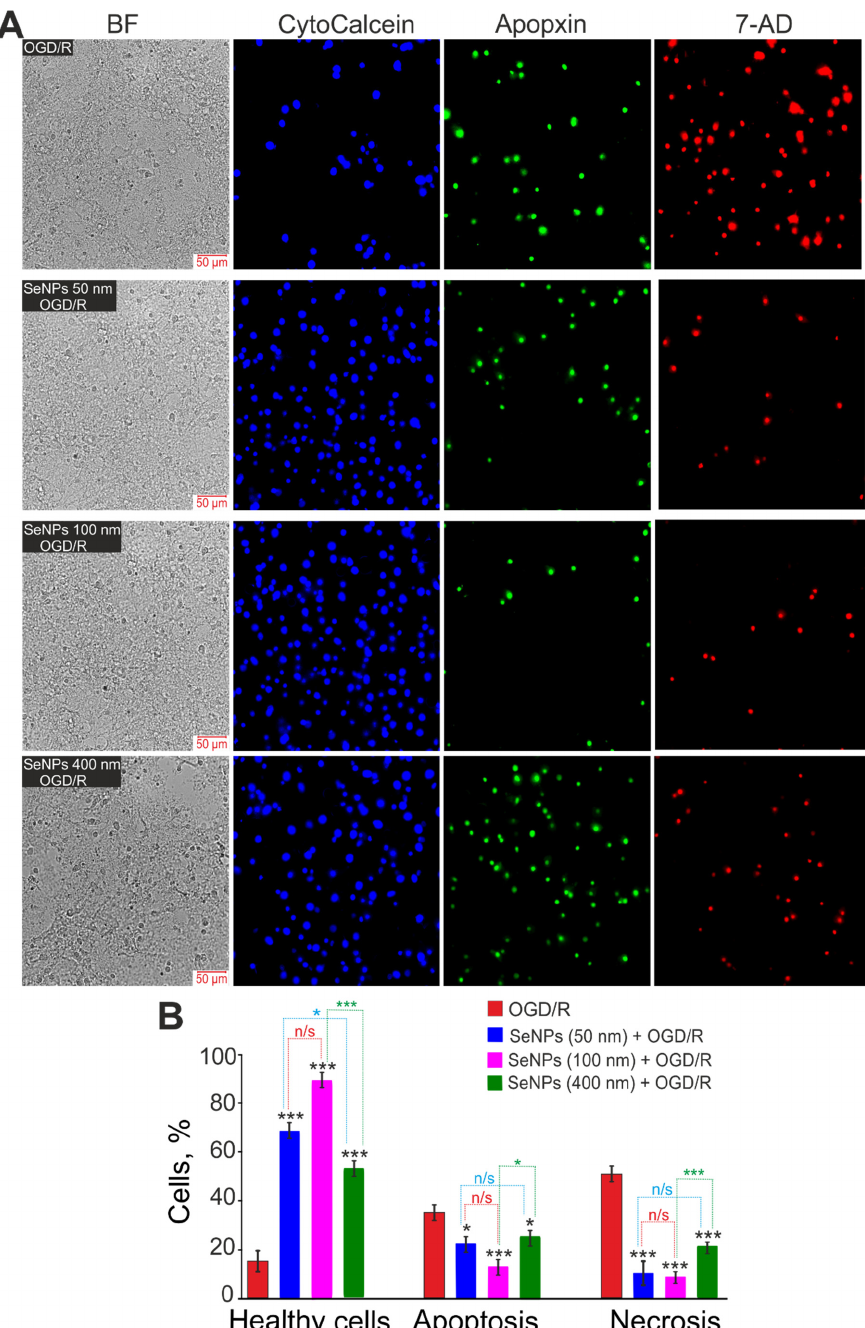
Figure 6. Effect of 24-h incubation of cortical cells with 3 μ g/mL of different-sized SeNPs and OGD/R on the induction of necrosis and apoptosis after 24 h OGD/R. ( A )—Cell staining using the Apoptosis/Necrosis Detection Kit assay. BF—bright-field microscopy, CytoCalcein—healthy cells indicator, Apopxin—apoptotic cells indicator and 7-AD (7-aminoactinomycin D)—necrotic cells indicator. ( B )—Healthy cells and cells with apoptosis or necrosis after incubation with 3 µ g/mL of different-sized SeNPs and OGD/R. Each value is the mean ± SE ( n ≥ 3). Black asterisks represent comparison of experimental groups versus OGD/R-group. Statistical significance was assessed using paired t -test; n/s—data not significant ( p > 0.05), * p < 0.05, and *** p < 0.001. Comparisons between experimental groups of different sized SeNPs are marked by red (50 nm-sized SeNPs vs. 100 nm-sized), green (100 nm-sized SeNPs vs. 400 nm-sized) or blue (50 nm-sized SeNPs vs. 400 nm-sized)